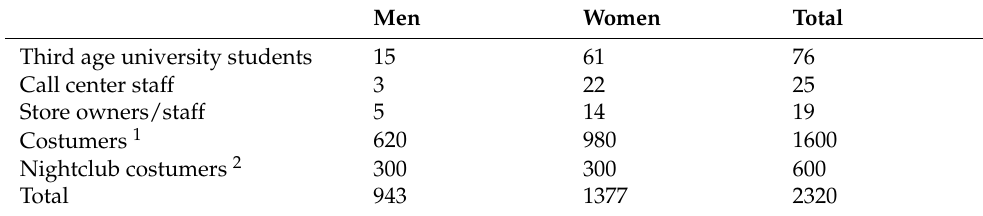
Figure 1. Market building ( A ), Weekly fair area ( B ), and Market building details ( C , D ). The building consists of 3 floors: the semi-underground floor (parking lot, warehouses, and the nightclub), the ground floor (supermarket, other small stores for regional products and services), and the top floor (restaurant, call center, hairdresser and the Third Age University). The building is open to the public from Monday to Sunday. The nightclub is open twice a week. The busiest day is Friday because of the weekly fair next to the market building). The number of Third Age University students, call center staff, store owners (including the hairdresser, restaurant, coffee shop, and supermarkets), and store and nightclub estimated customers/week is shown in Table 1. According to the data provided by the municipality, the mean monthly indoor water consumption from 2016 to 2018 was 250 ± 28 m 3 , showing no significant seasonal variation. This pattern aligns with [17], showing that indoor water consumption in buildings does not vary significantly throughout the year. Table 1. Estimate average number of market users/week.